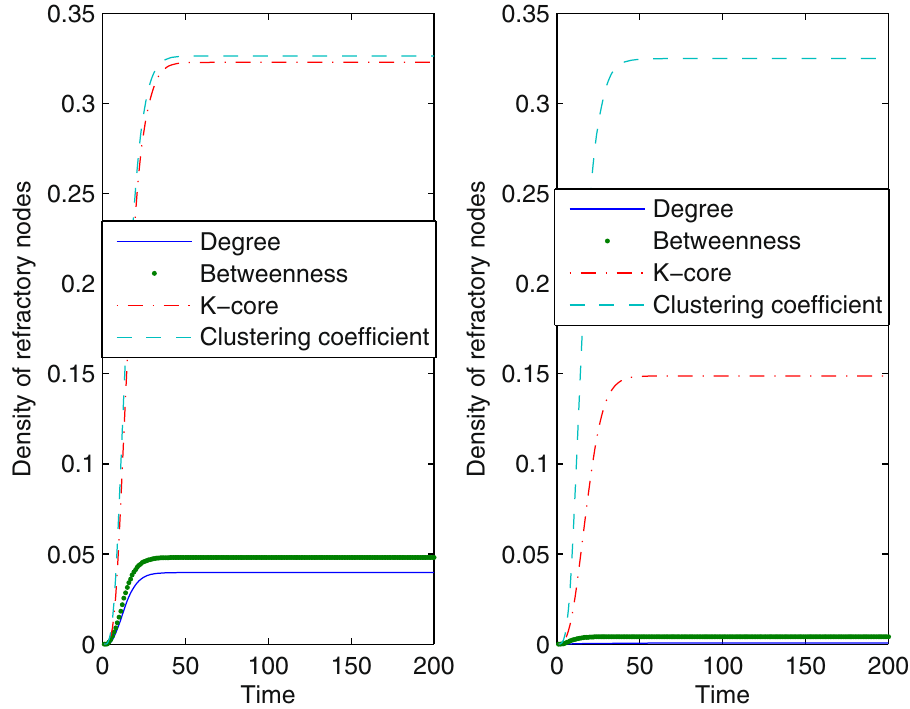
Figure 3. Density of refractory nodes as a function of time with the method of blocking different nodes. The underlying network is the real network, λ = 0.2, and δ = 0.2. In the left plot, the proportion γ is 0.01. In the right plot, γ is set at 0.05. Every plot is an average of 100 different